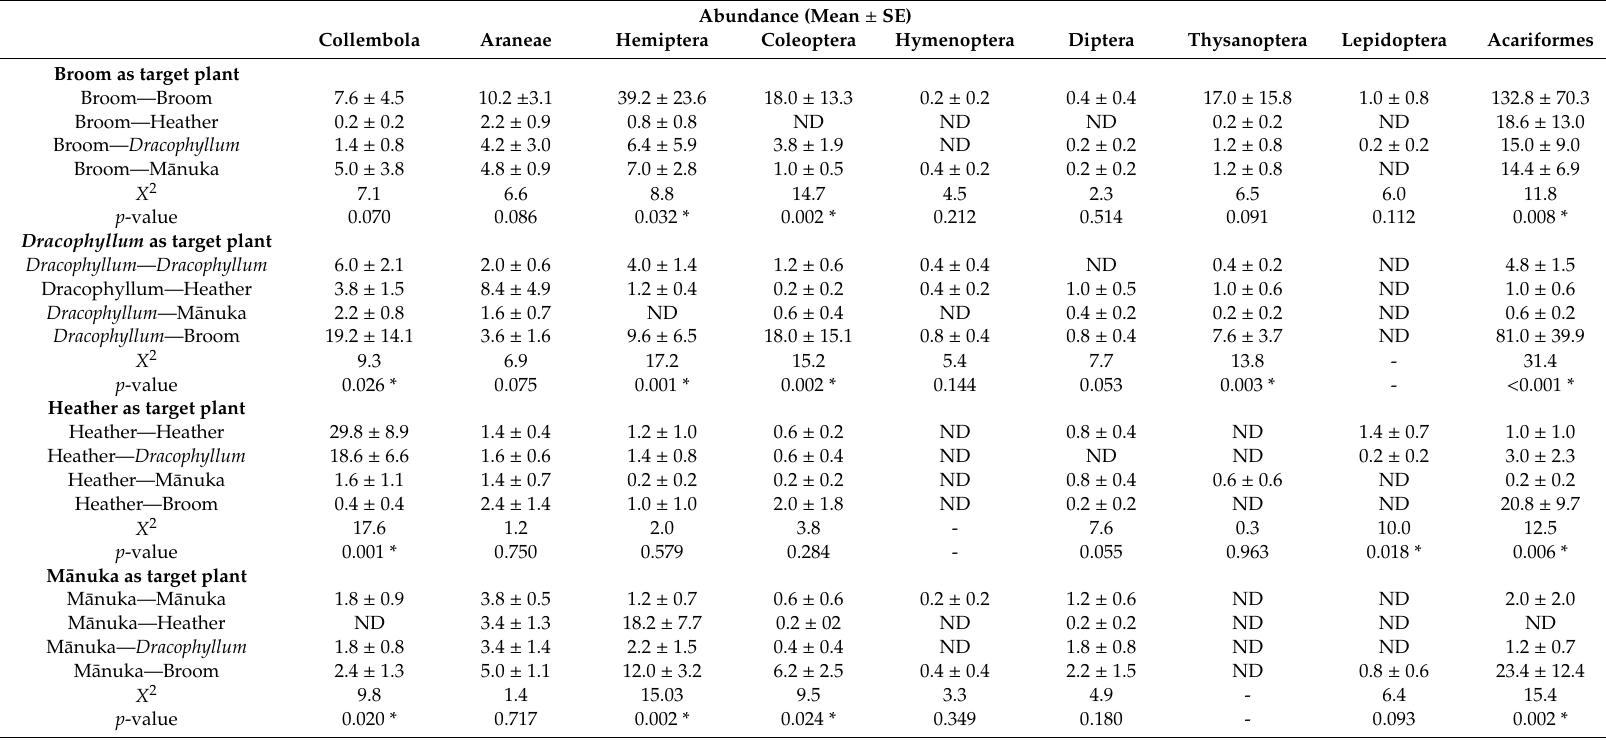
Table 5. Arthropods on target plants when paired with either conspecific or heterospecific neighbours in autumn. Arthropods were caught by beating a similar proportion of foliage of each target plant onto a tray ( n = 5). Comparisons between sites were performed using a negative binomial generalised linear model. Site was used as the predictor, while arthropod groups were the response variables. The likelihood ratio test was used to assess the significance of the